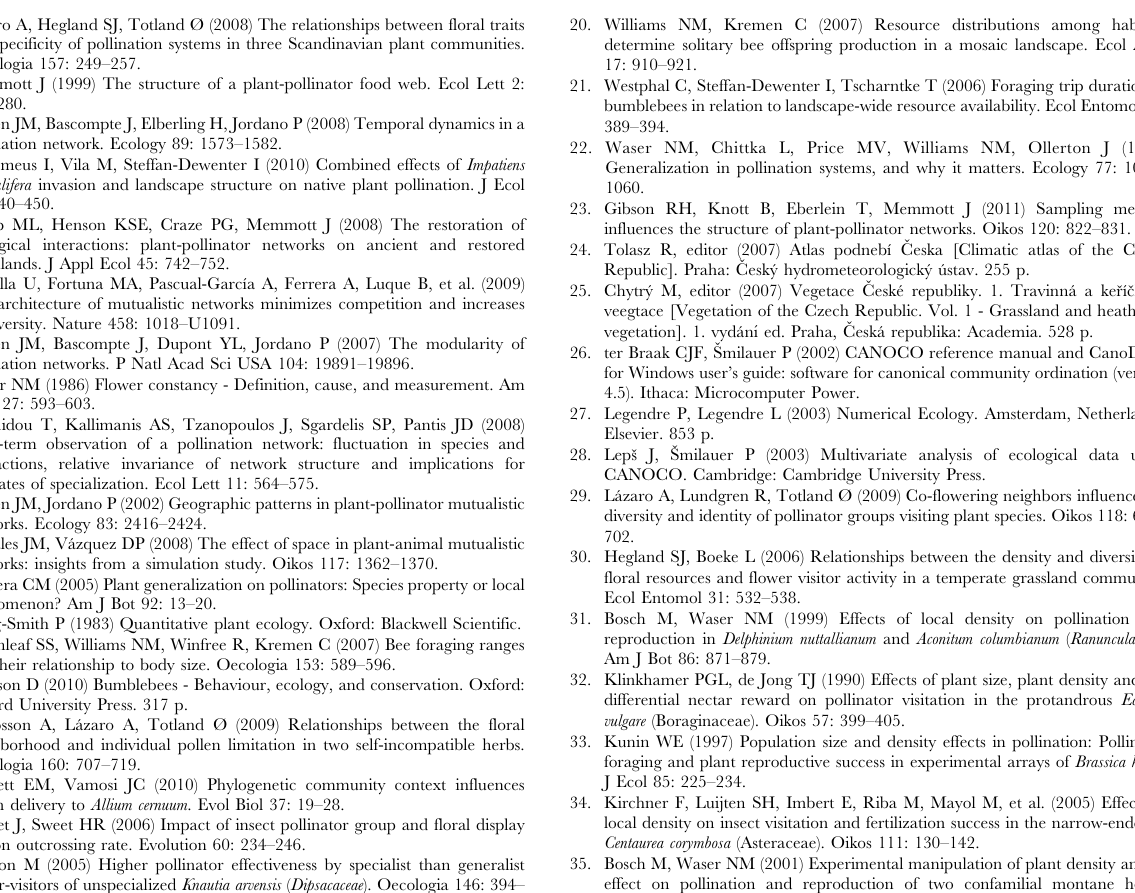
Figure S6 Ordination diagram of RDA analysis of pollinator densities on Sanguisorba officinalis . Forward selection has identified as environmental variables included into the final model only logarithm of flowering stalk abundance of S. officinalis (log S. officinalis); plots are categorized according to the sector of origin (see Fig. 1 for definition of sectors); 1 st ordination axis explains 46.0% of total variability in pollinator density, 2 nd axis explains 44.4%. Figure S7 Ordination diagram of RDA analysis of pollinator densities on Trifolium hybridum , forward selection has identified as environmental variables included into the final model only logarithm of flowering stalk abundance of Ranunculus acris (log R. acris). plots are categorized according to the sector of origin (see Fig. 1 for definition of sectors); 1 st ordination axis explains 18.7% of total variability in pollinator density, 2 nd axis explains 54.4%. Figure S8 Maps of occurrence and abundance of the eight focal plant species pollinator assemblages